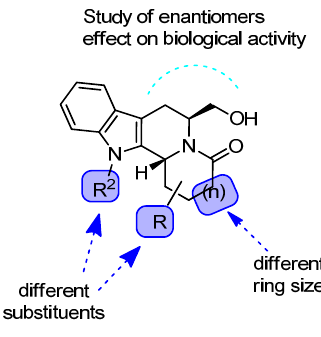
Figure 2. Compounds to be synthesized.